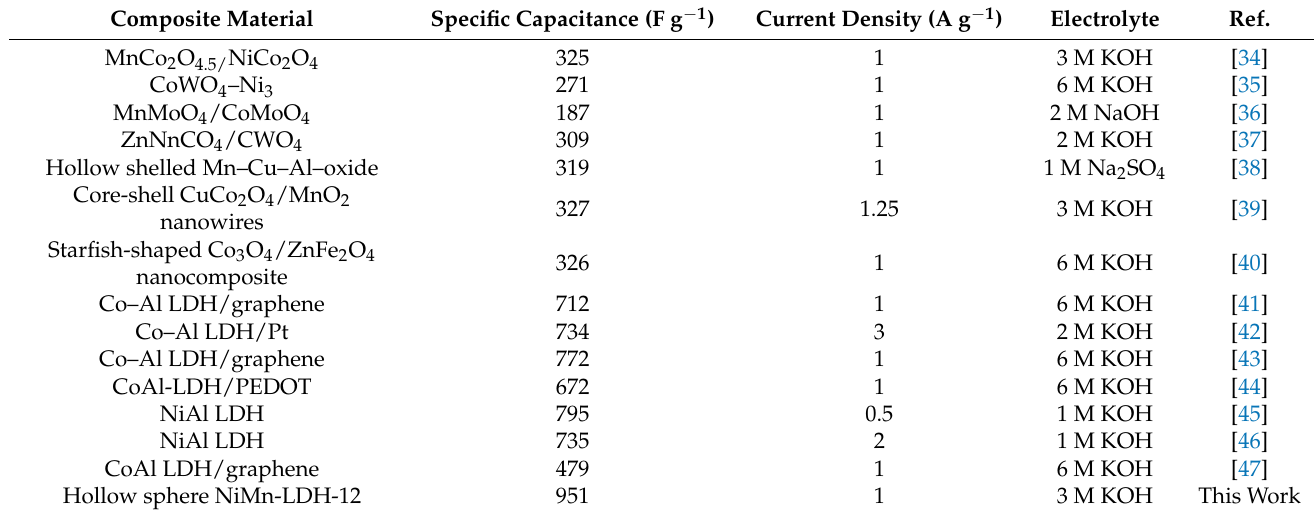
Table 1. Analytical comparison of NiMn-LDH-12 with similar reported